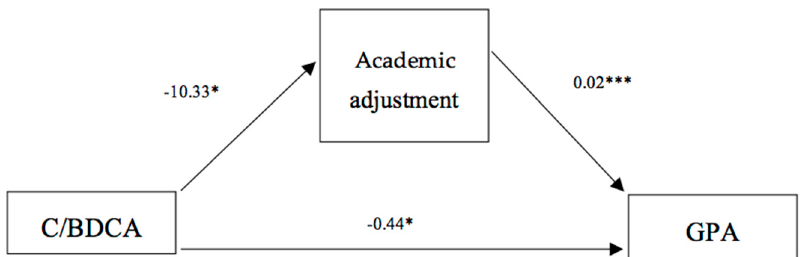
Figure 2. ( a ) Academic performance in the different groups; ( b ) Academic adjustment in the different groups. GPA and academic adjustment were lower in the BDCA group. BD: binge drinking. BDCA: binge drinking and co-consumption of cannabis.